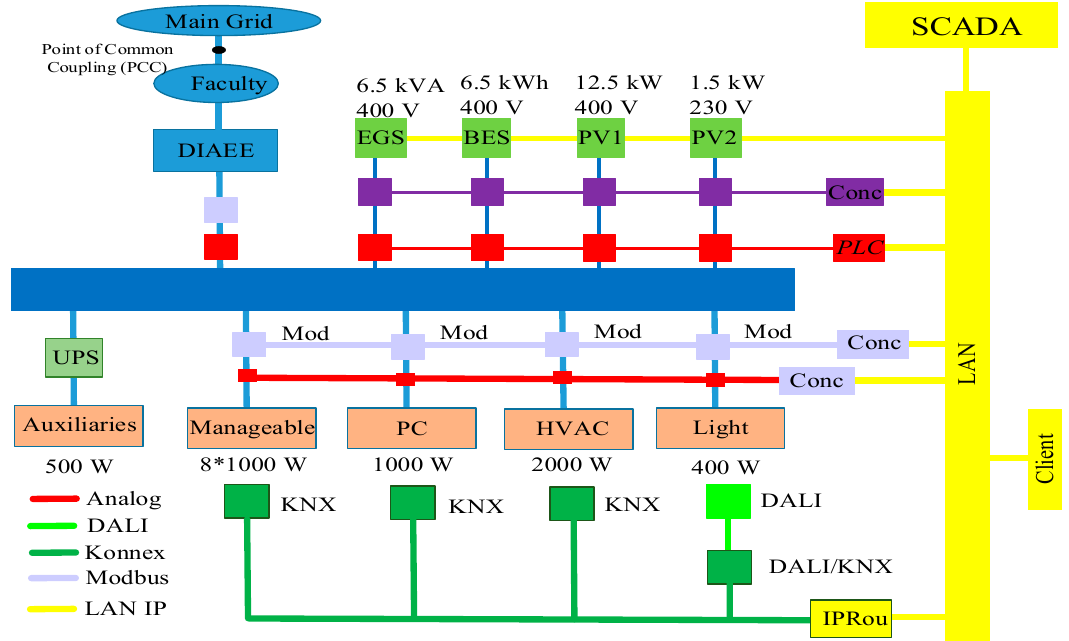
Figure 8. Total PV production per month in 2019.